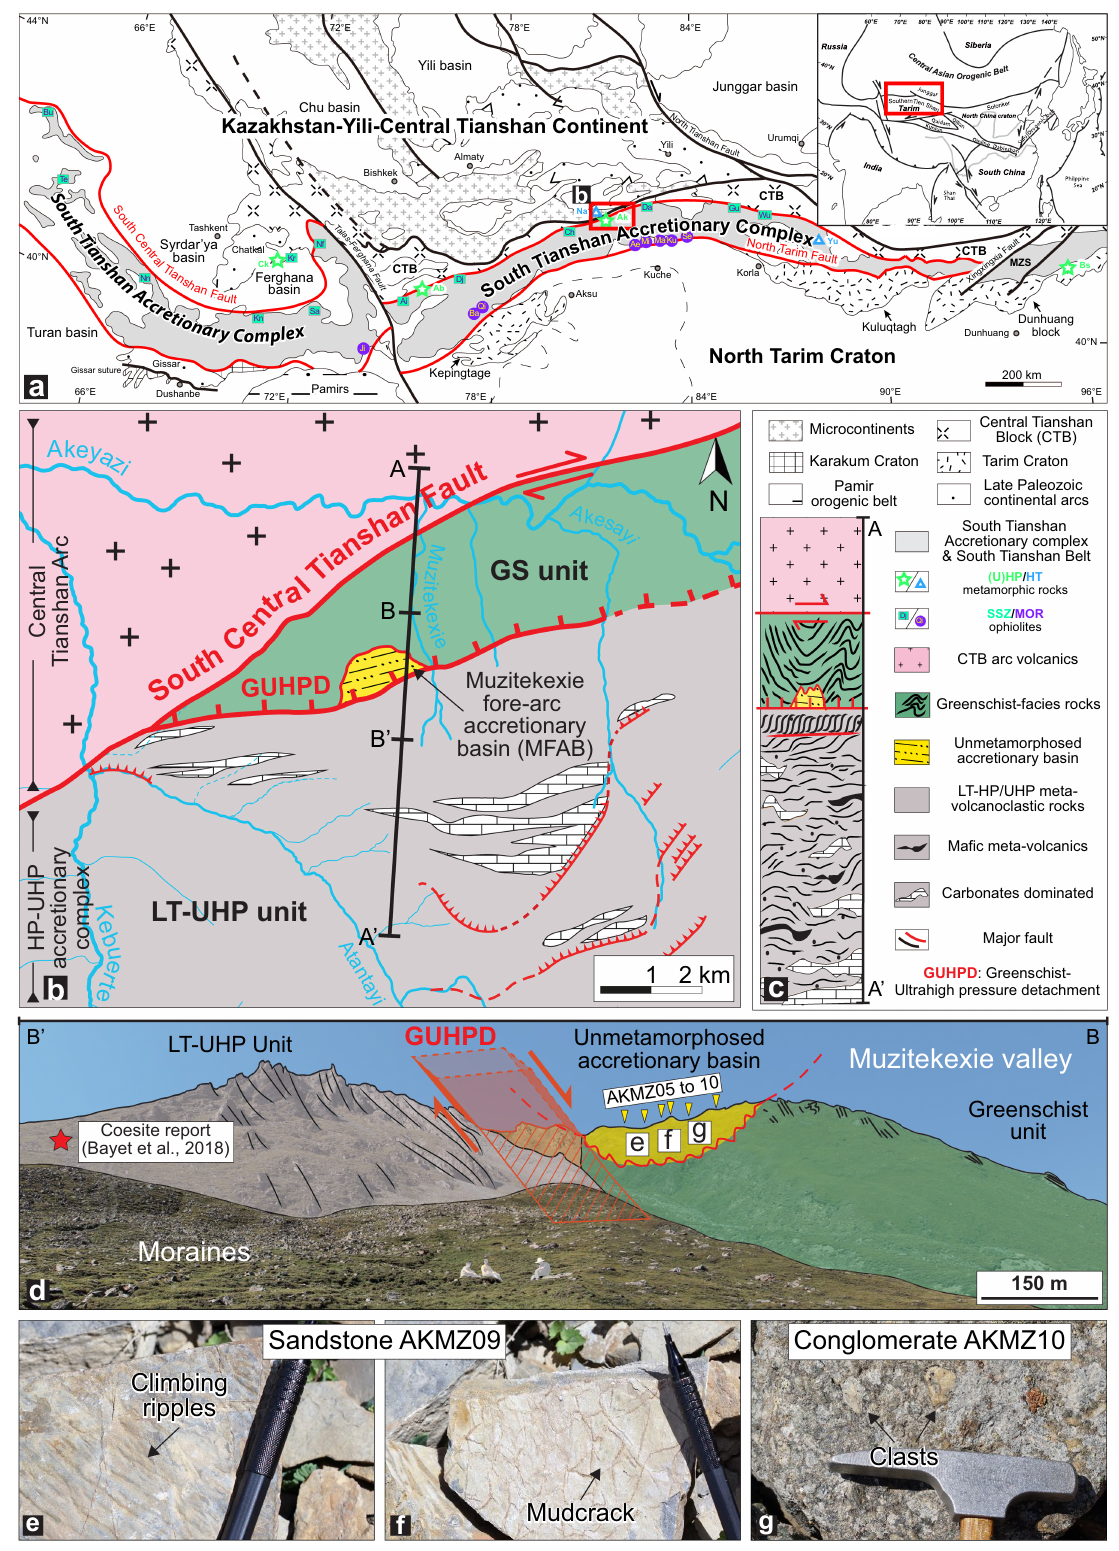
Fig. 1 Tectonic framework and outlook of the studied area. a Map of the southern Altaids, modi fi ed after ref. 19 . b Regional geological map of the AMC in Chinese STO, modi fi ed after refs. 27,30 . c Synthetic and schematic lithological pro fi le, along the cross-section from north (top, A) to south (bottom, A ’ ). d Field view of the Muzetekexie valley, modi fi ed after 98 ; the dotted part of the line represents a more diffuse nature of this contact, and the studied unmetamorphosed basin is unconformably overlying the greenschist-unit. e Climbing ripples observed in sandstone outcrops. f Mud-crack preserved in sandstone crops. g Several cent-meters scale clasts in conglomerate outcrop.